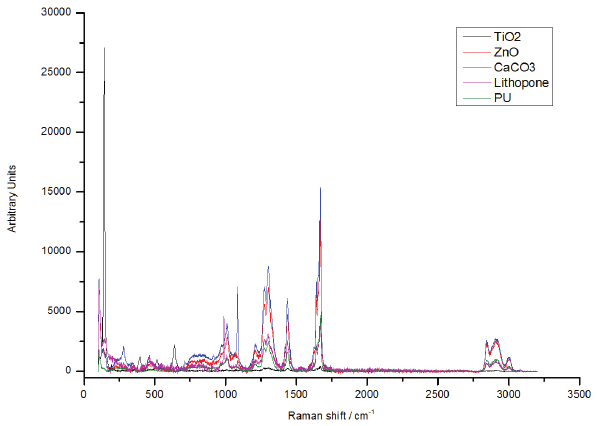
Figure 3: Raman spectra of microcomposites of elastomeric PU with different mineral fillers and neat PU.